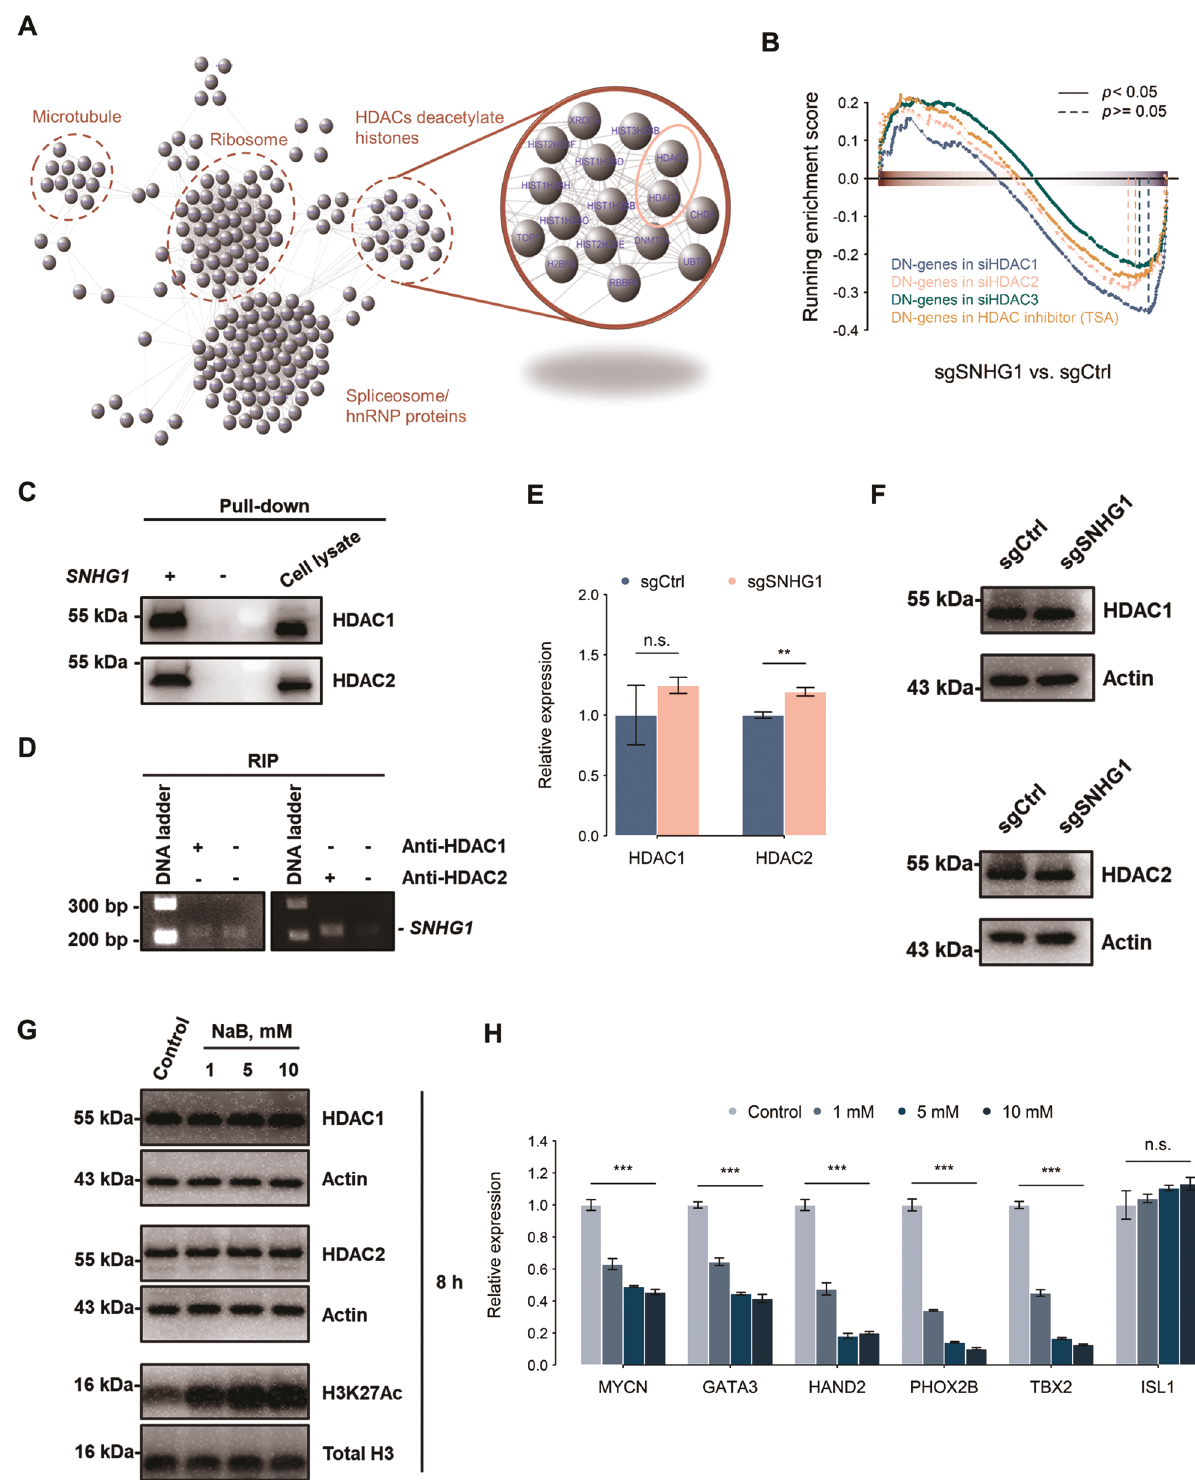
Fig. 5 HDAC1/2 interacts with SNHG1 . A Functional association network of SNHG1 -interacting proteins constructed by STRING database. B The gene expression signature from cells with HDAC inhibition (TSA treatment or siHDAC) was associated with SNHG1 depletion (sgSNHG1). C RNA-protein pull-down assay to detect HDAC1/2 interaction with SNHG1 via western blot. D RNA immunoprecipitation (RNA-IP) validated the HDAC1/2 interaction with SNHG1 . E , F The RNA level and protein level of HDAC1/2 were measured by qRT-PCR (E) ( n = 3) and western blot ( F ) in control sgRNA (sgCtrl) or SNHG1 -speci fi c sgRNA (sgSNHG1) in SK-N-BE(2)C cells. The expression levels were normalized to endogenous GAPDH or actin. G The protein level of HDAC1/2 and acetyl-K27 of histone H3 in the sodium butyrate (NaB)-treated cells. The expression levels were normalized to endogenous actin or histone H3. H CRC gene expression levels measured by qRT-PCR after DMSO (control) or NaB treatment (1, 5, and 10 mM) in SK-N-BE(2)C cells. The expression levels were normalized to endogenous HPRT . Data in F and G were representative of three independent experiments. * p < 0.05, ** p < 0.01, *** p < 0.001 from t -test. Cell Death and Disease (2022)